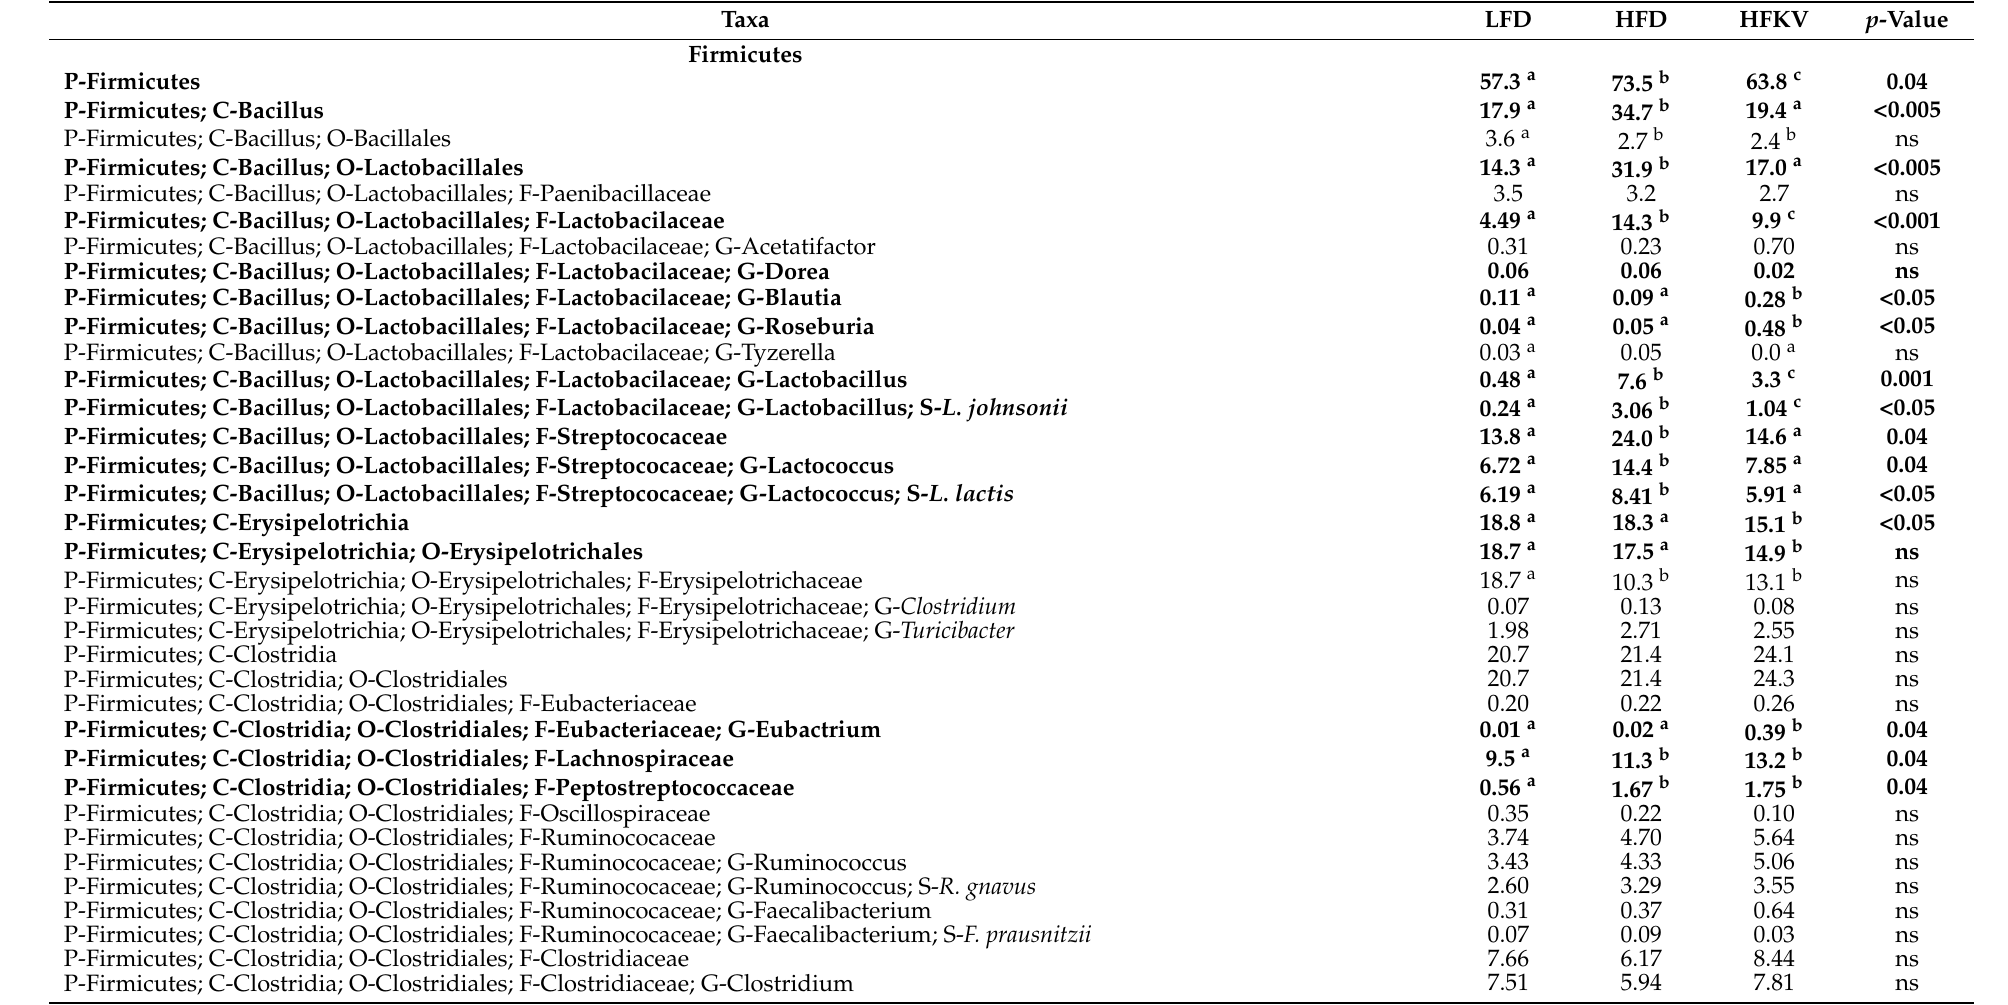
Table 5. Relative abundance of different taxa between the 3